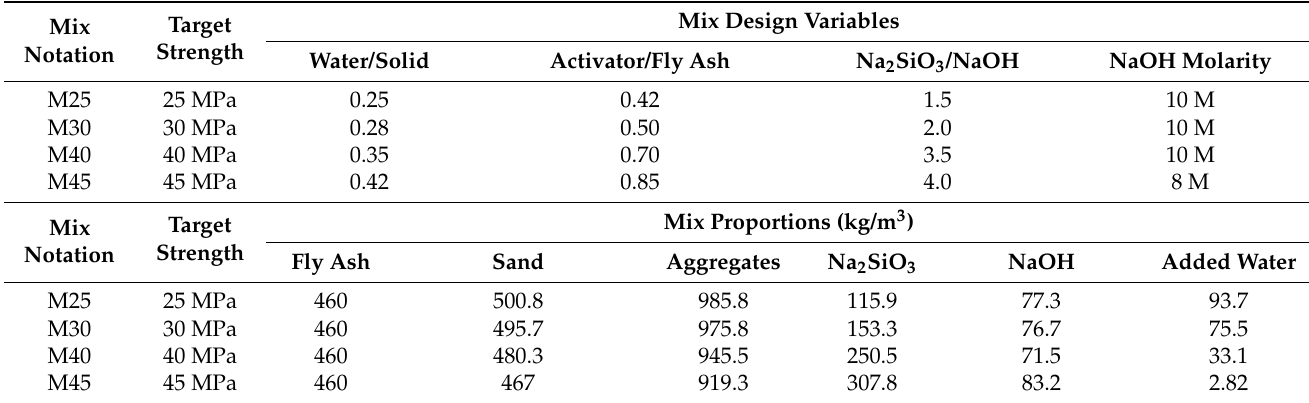
Table 4. Mix proportions of high calcium fly ash geopolymer concrete.